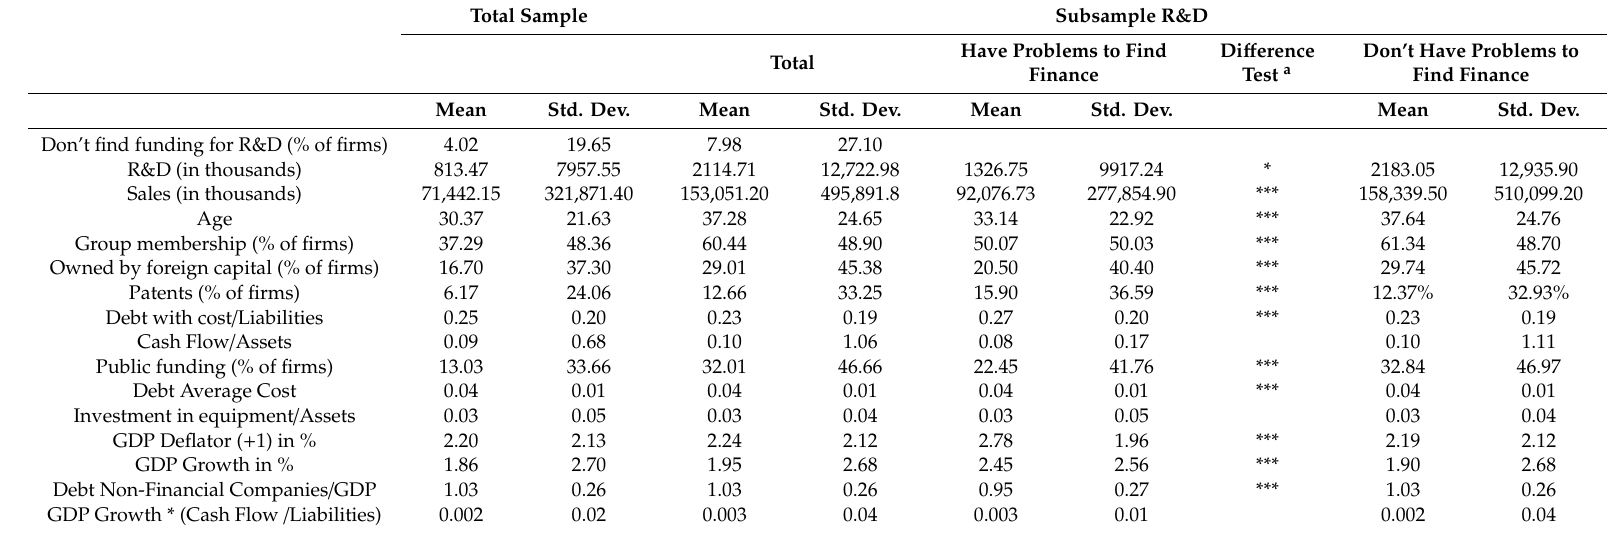
Table 1. Descriptive statistics of principal